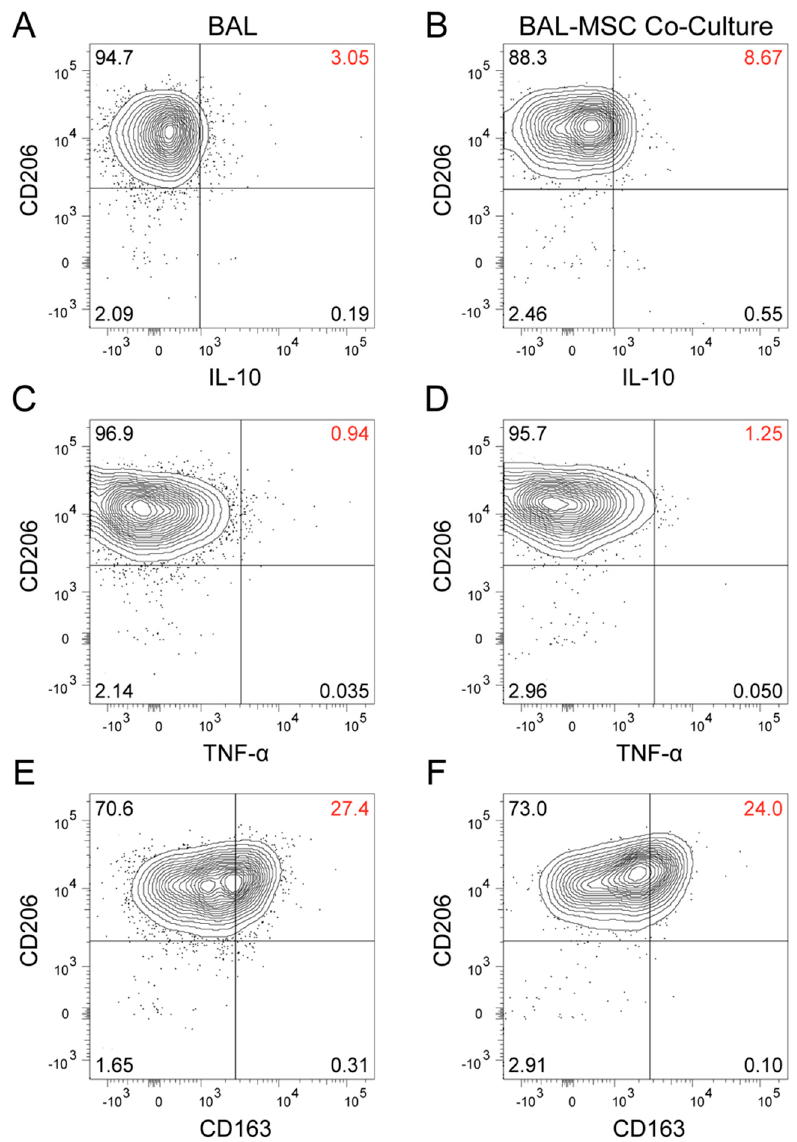
Figure 4. Flow cytometry analysis of mononuclear cells (73% of which were macrophages) freshly prepared from a sarcoidosis subject (sarcoidosis subject 17). Bronchoalveolar lavage (BAL) cells were